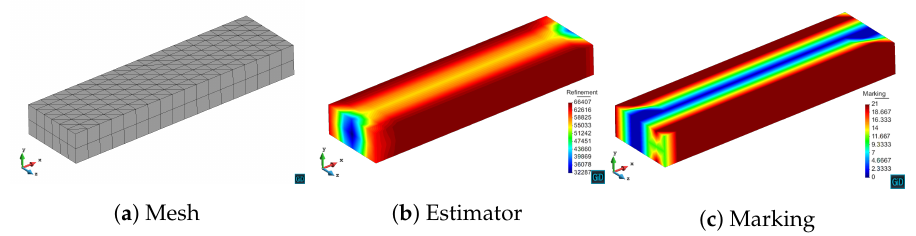
Figure 14. First iteration for a structured mesh of a WR-90 waveguide.